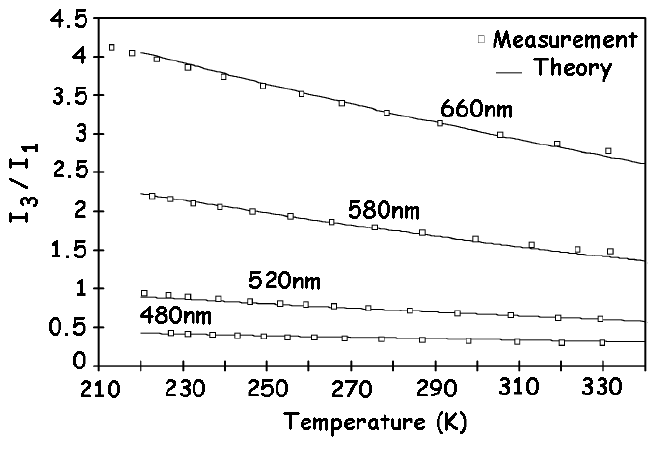
/I versus temperature 3 1